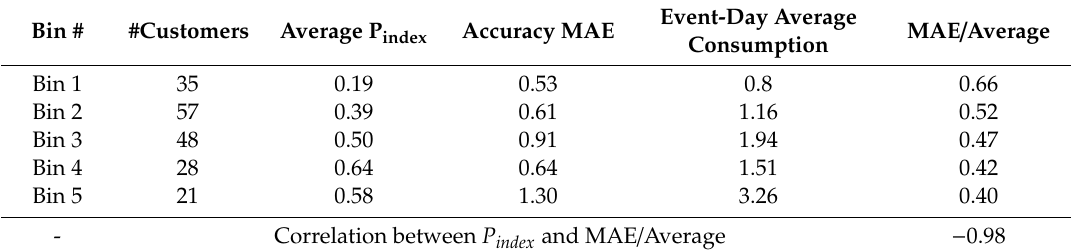
Table 3. The accuracy results of the California ISO (CAISO) customer baseline (CBL) calculation method.